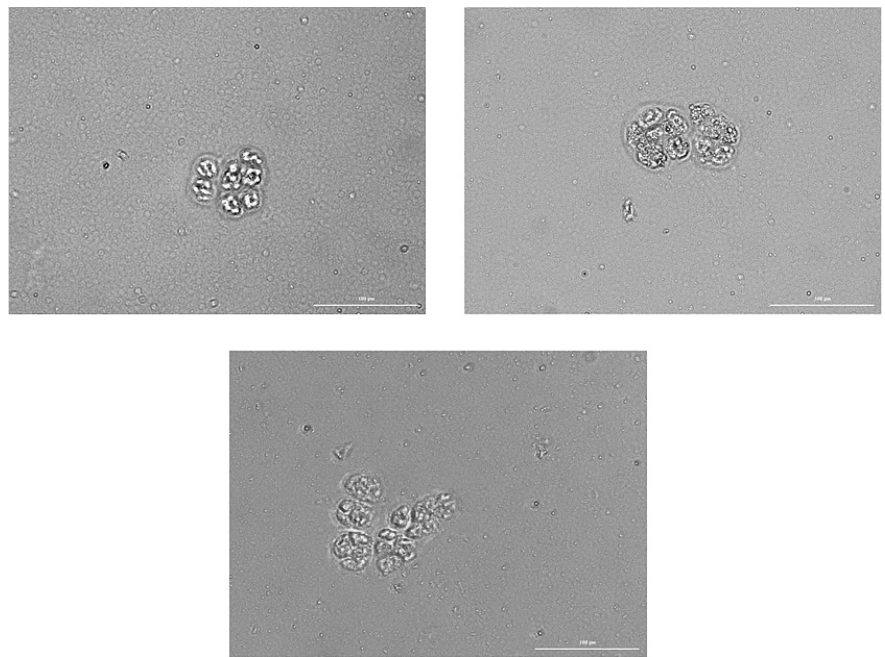
Figure 14. Representative images of spheroids in culture of the adherent fraction of mononuclear cells from patient G after 14 days of culture. Images were obtained using the Cytation 5 Multi-Mode Reader. Native preparations. All scale bars are 100 µm.